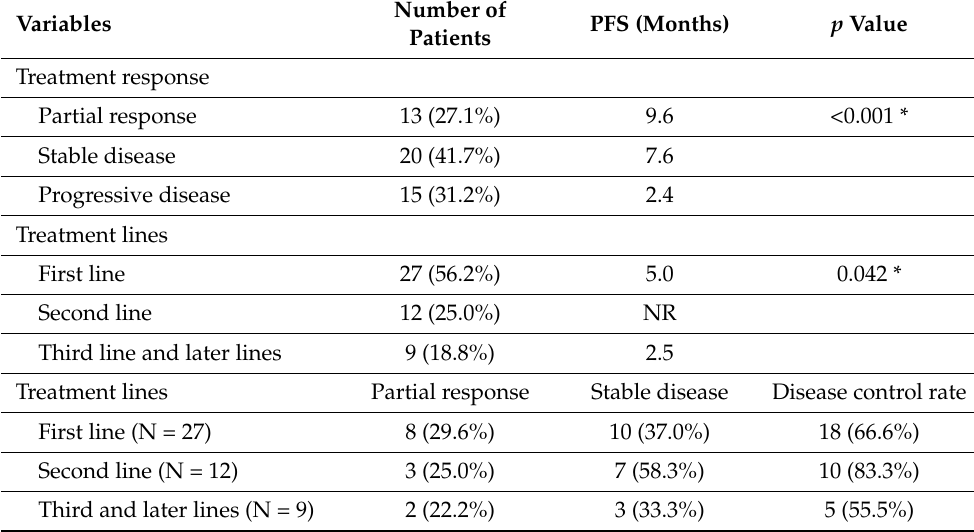
Table 2. Analysis of progression-free survival (PFS) according to the response rates and treatment lines of atezolizumab plus